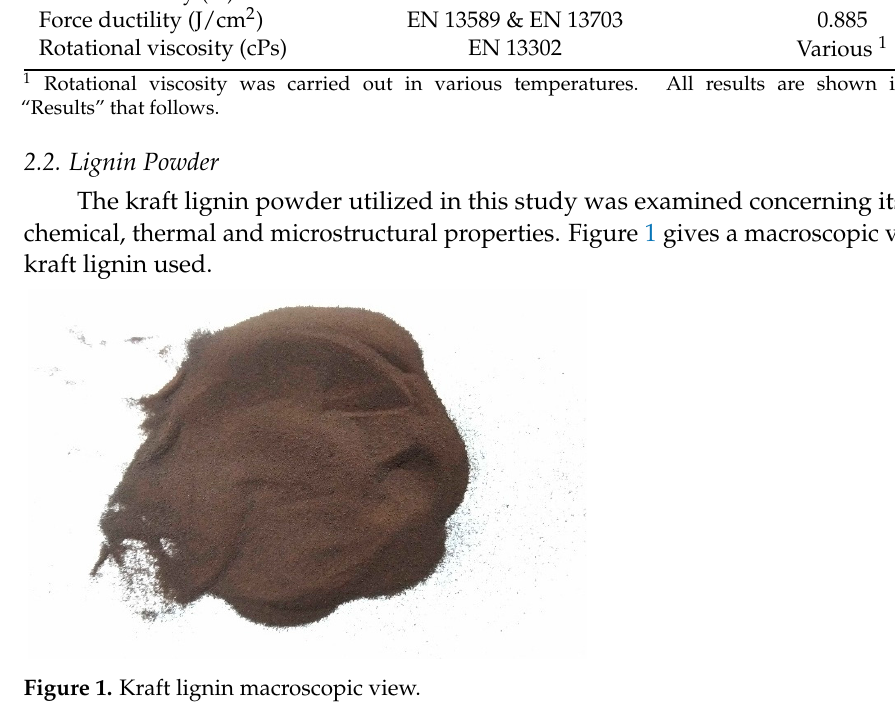
Figure 1. Kraft lignin macroscopic view .